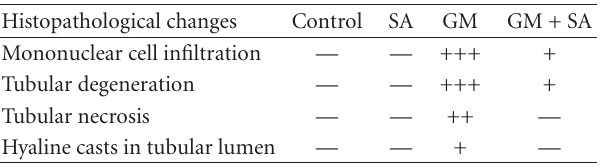
Figure 2: E ff ect of gentamicin (GM), salicylic acid (SA), and their combination on protein carbonyl content in kidney tissues of rats. Values are means ± SD. ∗ P < 0 . 001 versus control and SA; # P < 0 . 01 versus GM. Table 2: Grading of histopathological changes in the kidney